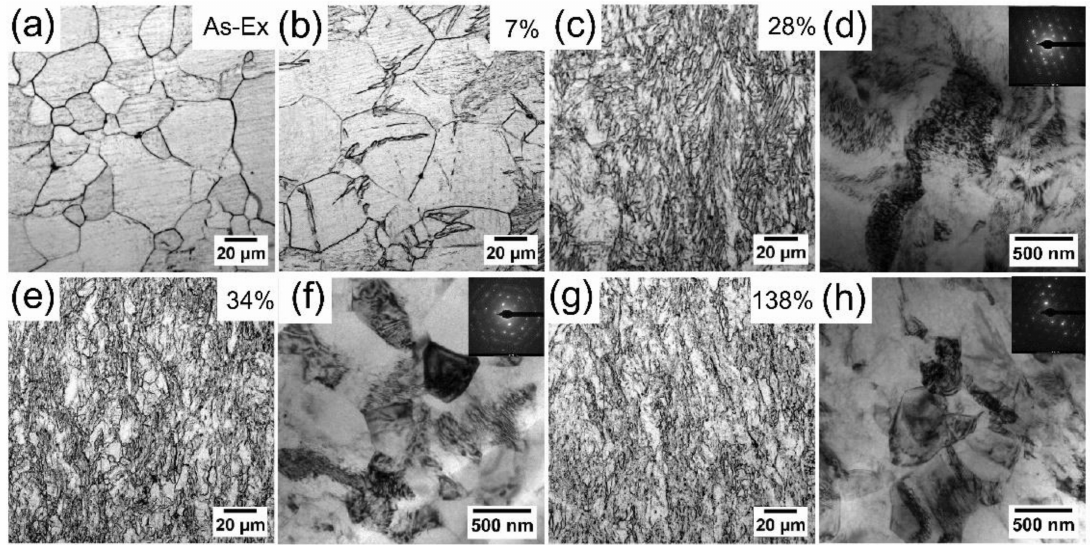
Figure 2. Metallographic photos of ( a ) as-extruded and as-drawn Mg with ATS of ( b ) 7%, ( c ) 28%, ( e ) 34%, ( g ) 138%, and ( d ) ( f ) ( h ) TEM micrograph of wire with corresponding ATS (28%, 34%,